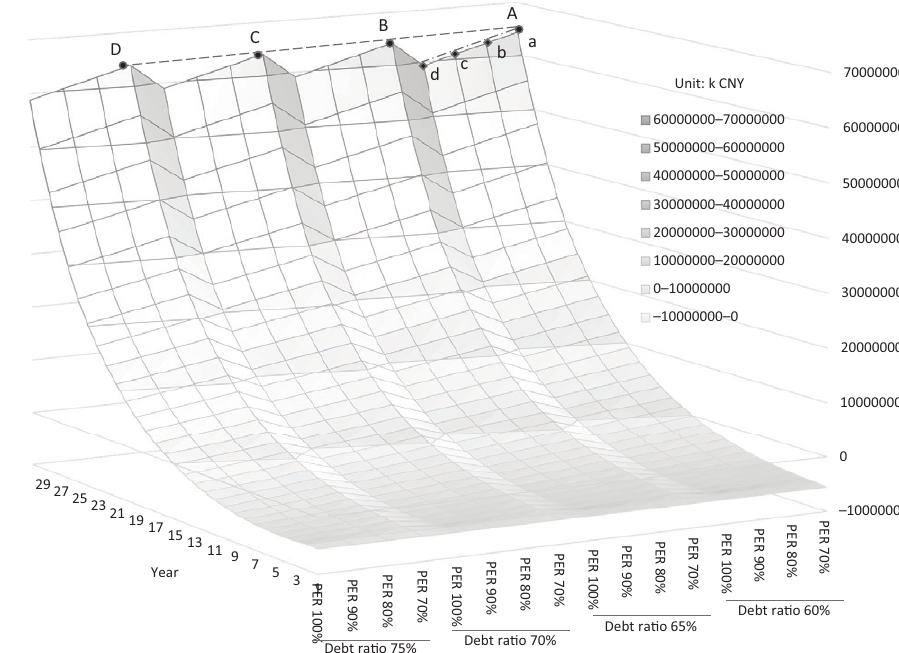
Figure 10. Simulation results for SCS influenced by different financing strategies